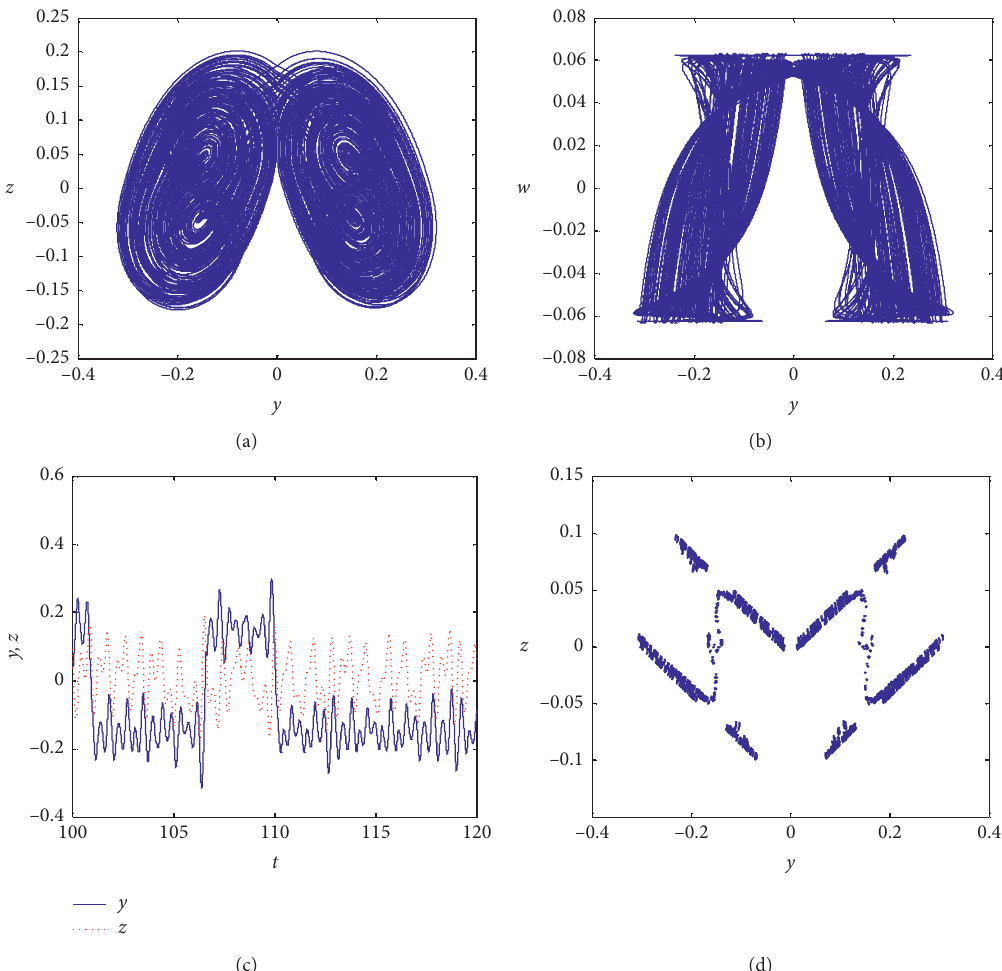
Figure 1: Numerical simulations for the proposed multiscroll chaotic system under mode 1: M ( − , +). (a) y versus z , (b) y versus w , (c) t versus y and t versus z , and (d) Poincar´e map in y versus z under x � y